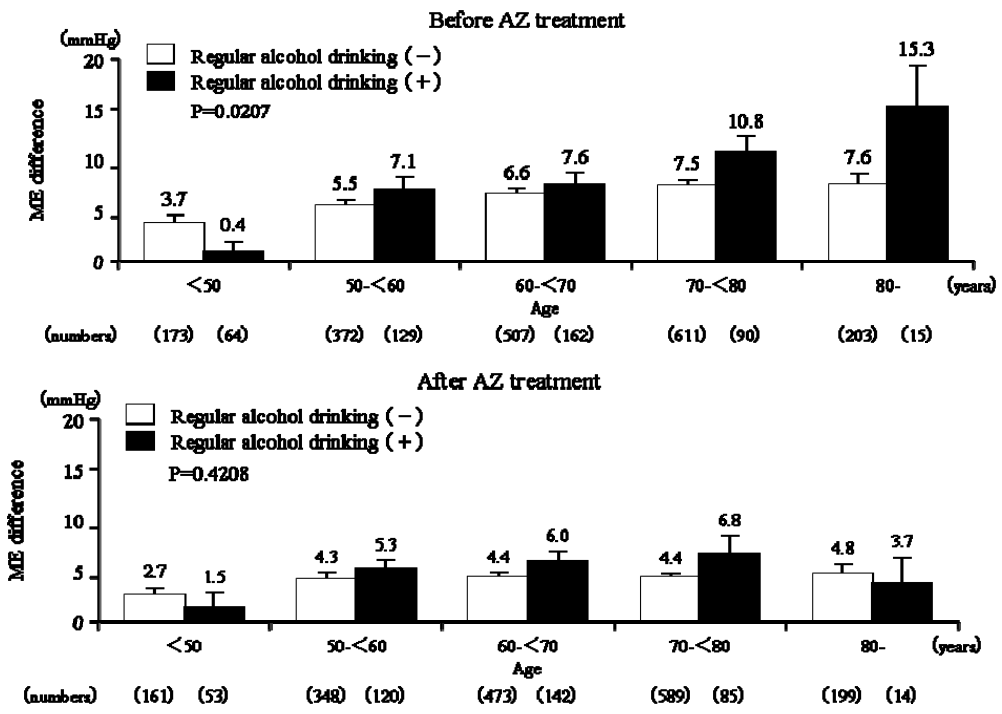
Figure 5. ME-Dif in patients with or without regular alcohol drinking stratified according to age before and after treatment with